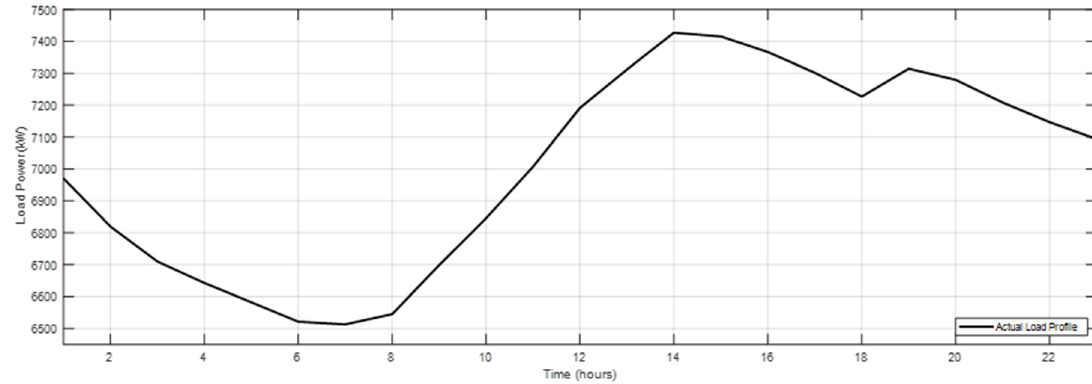
Figure 8. Maximum daily load profile in Dammam city.